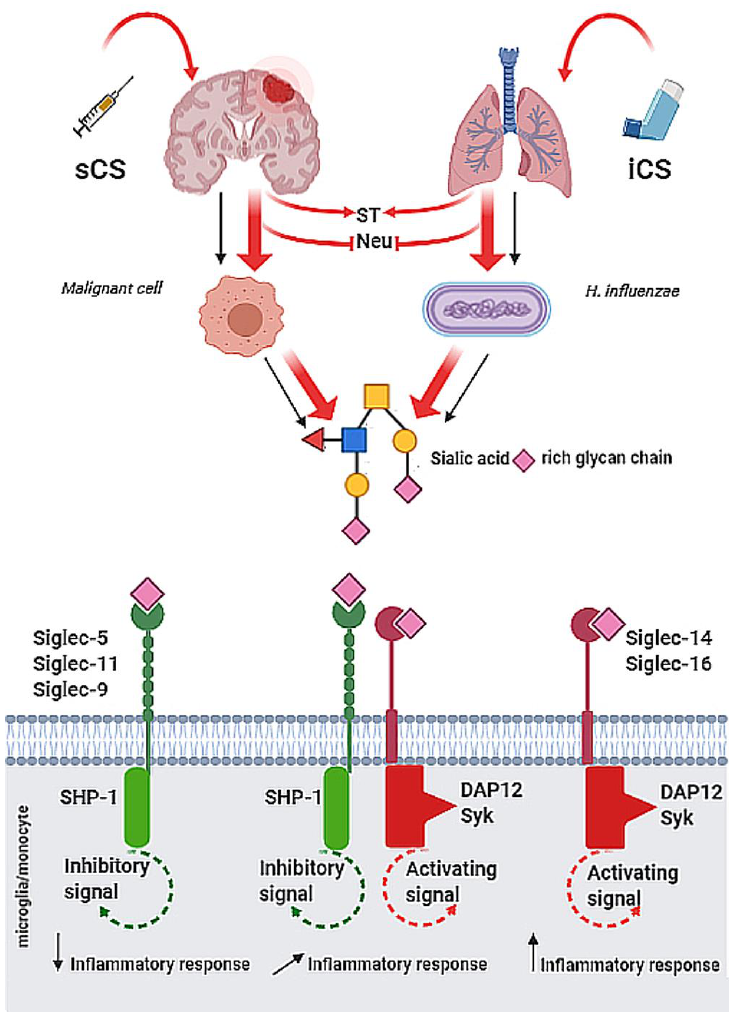
Figure 1. Possible e ff ects of systemic (sCS) and inhaled corticosteroids (iCS) on immune functions via sialoglycan-Siglec checkpoint. The administration of sCS and / or iCS modulates the expression and activity of sialyltransferases (ST) and neuroaminidases (Neu) that result in changes of cell surface sialylation pattern. Depending on inhibitory and activatory Siglec expression in individuals, the binding of specific sialic acid ligands exerts the immune response of di ff erent intensity in selected pathological